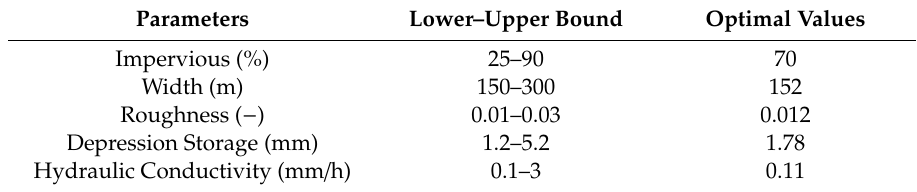
Figure 9. Scatter plots of observed and simulated lakes level during the spin up ( a ), calibration ( b ), and validation ( c ) periods. The lines are the linear regression fit with 95% confidence intervals. Table 3. Model parameters upper and lower limits, as well as their optimal values.